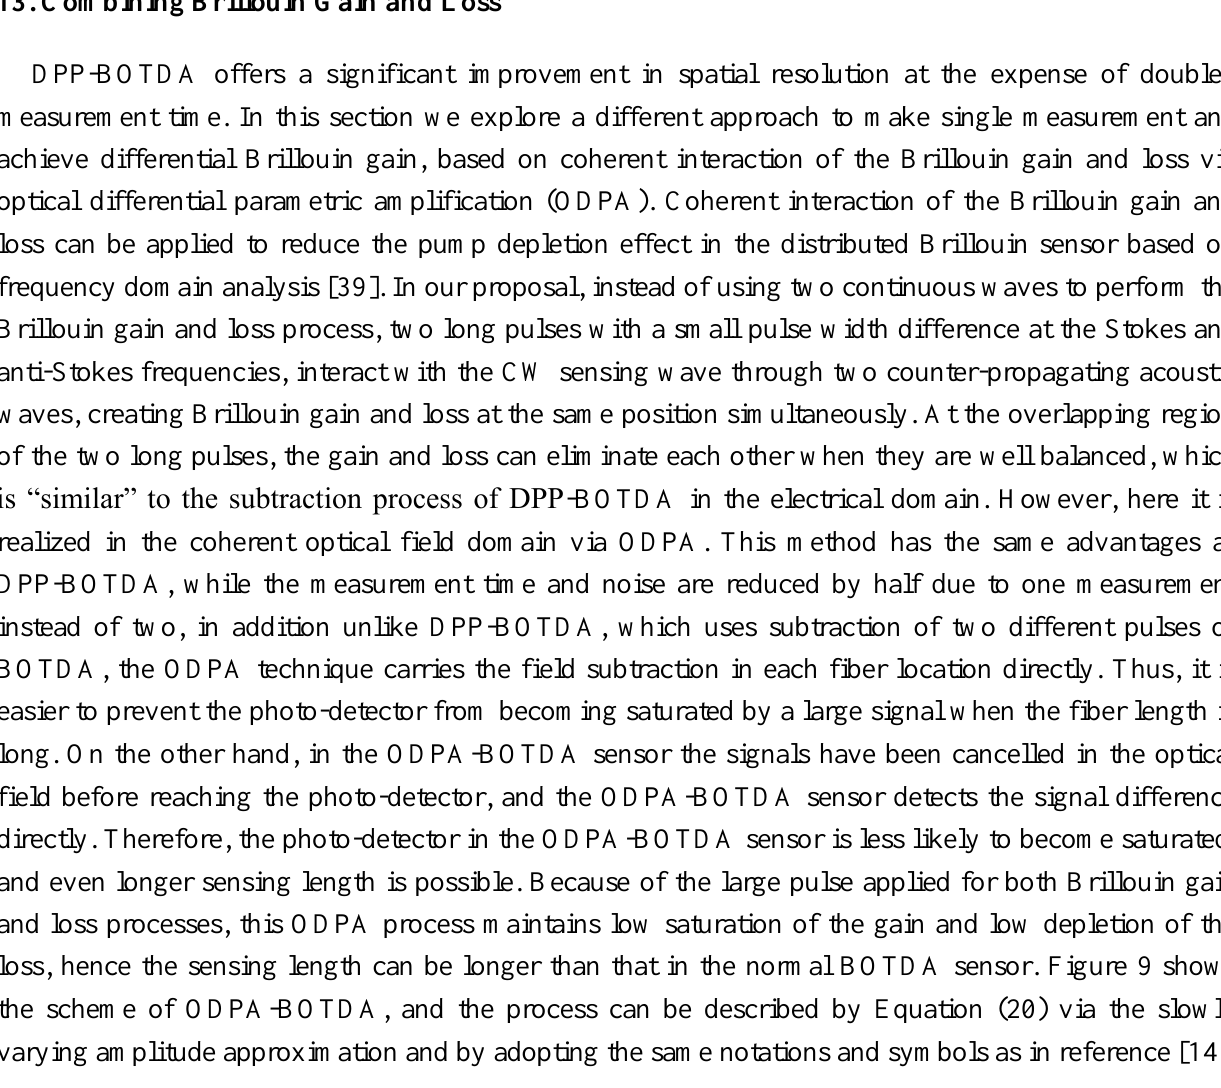
Figure 9. Schematic diagram of the ODPA-BOTDA [45] (Copyright © 2010 OSA, Reprinted with